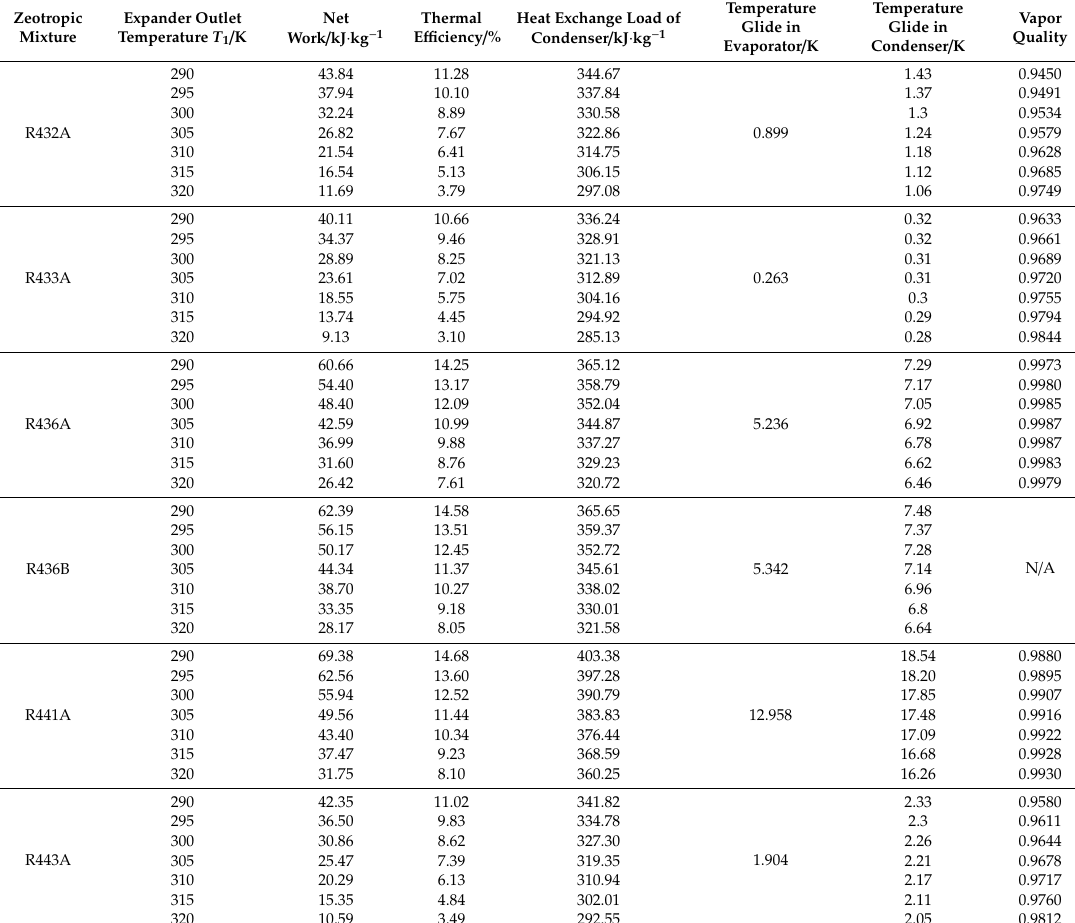
Table 5. Thermodynamic performance of six zeotropic mixtures when expander outlet temperature is